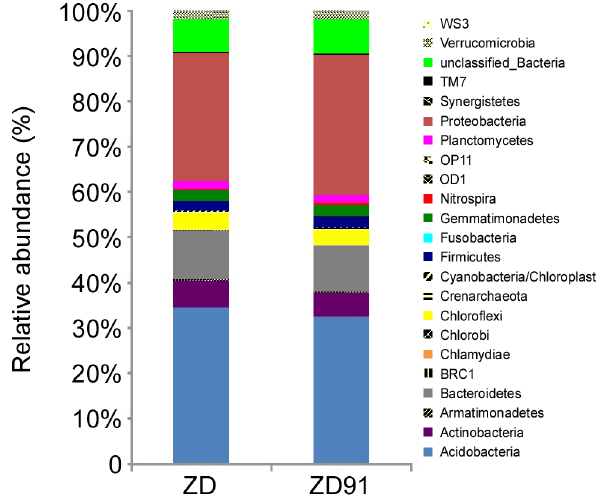
Figure 2. Bacterial composition at the phylum level. Relative read abundance of bacterial phyla within the communities. Sequences that could not be classified into any known group were assigned as unclassified_Bacteria.